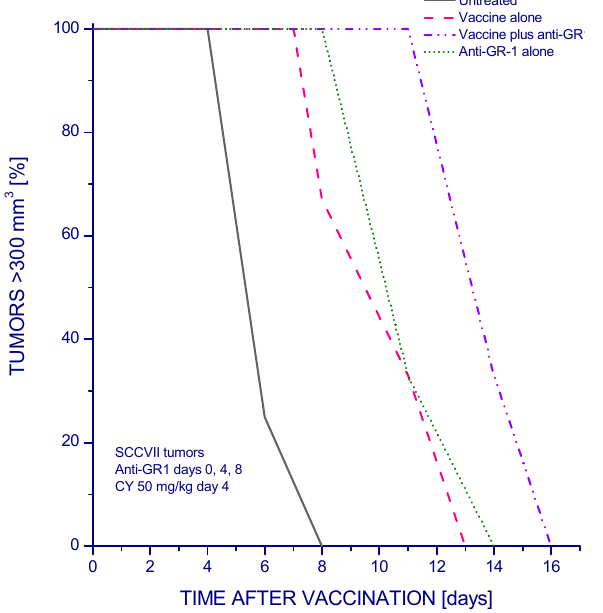
Figure 4. The effect of multiple anti-GR1 treatment on the response of SCCVII tumors to PDT vaccine. The mice received PDT vaccine treatment as described for Figure 3 but were also administered cyclophosphamide (50 mg/kg i.p.) at day 4 post vaccination. Anti-GR1 (0.1 mg/mouse i.v.) was injected on days 0, 4, 8 relative to the time of vaccination. The response to therapy was evaluated by tumor size measurement and is presented as percentages of mice with tumors smaller than 300 mm 3 in function of time after vaccination. Each treatment group consisted of 6 mice. Statistically significant ( p < 0.05) were the differences between the control untreated group response and all the three treated group responses, and between vaccine alone and vaccine plus anti-GR1 group.